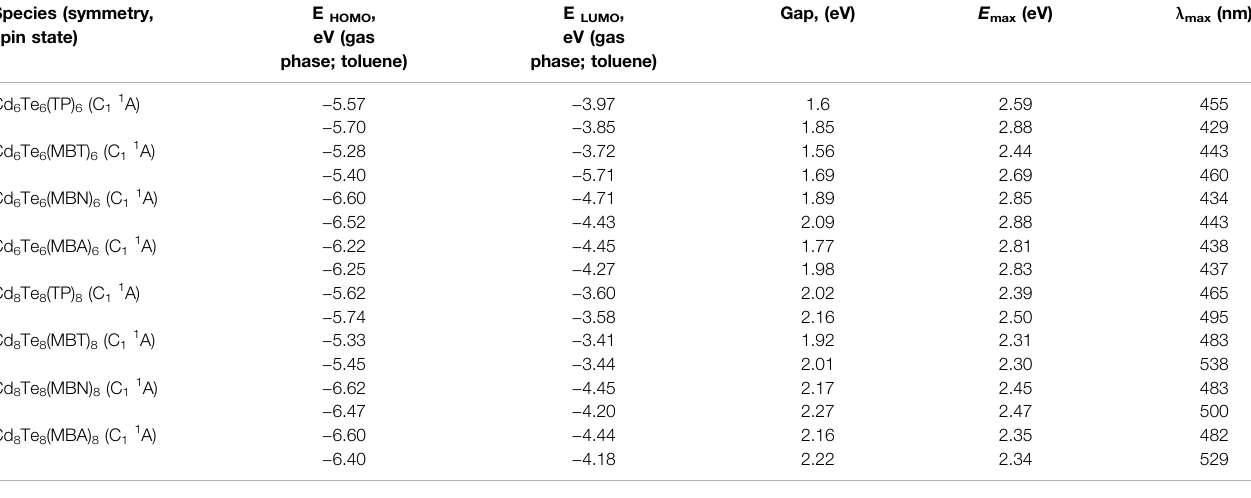
TABLE 6 | Calculated E HOMO energy (eV), E LUMO energy (eV), HOMO-LUMO gaps (eV), excitation energies ( E max ) (eV), and maximum absorption wavelengths ( λ max ) (nm), of the excited states with maximum oscillator strength of capped Cd n Te n L n ( n (cid:1) 6 and 8) QDs (where L (cid:1) TP, MBT, MBN, and MBA) in the gas phase and toluene. Species (symmetry, E HOMO , E LUMO , Gap, (eV) spin state) eV (gas eV (gas phase; toluene) phase; toluene)